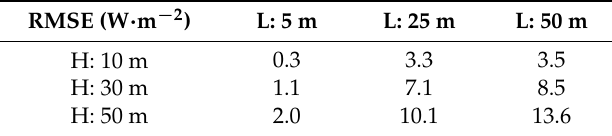
Table 4. RMSE of the estimation of R ↓ s expressed in W · m − 2 .